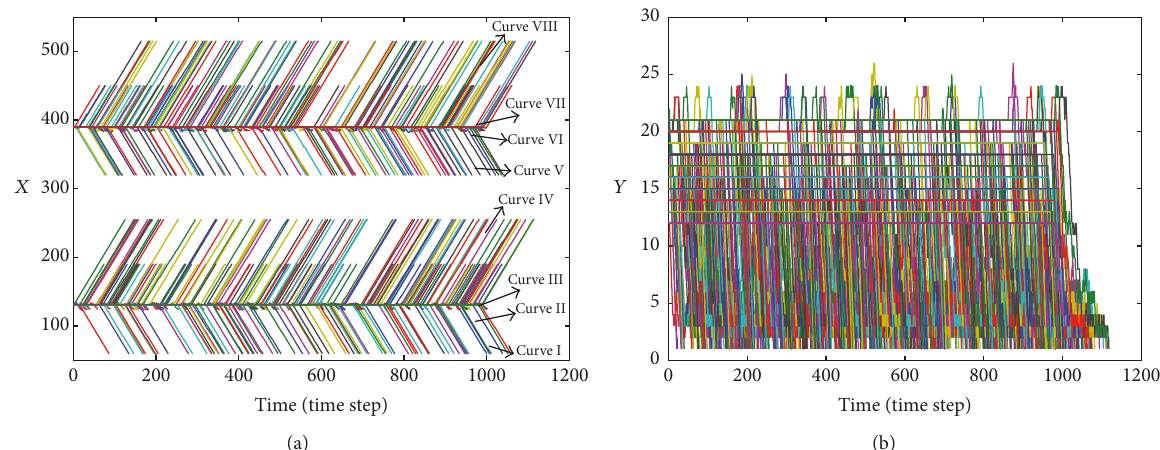
Figure 6: Each pedestrian’s trajectory, where (a) is the 𝑥 -direction and (b) is the 𝑦 -direction.